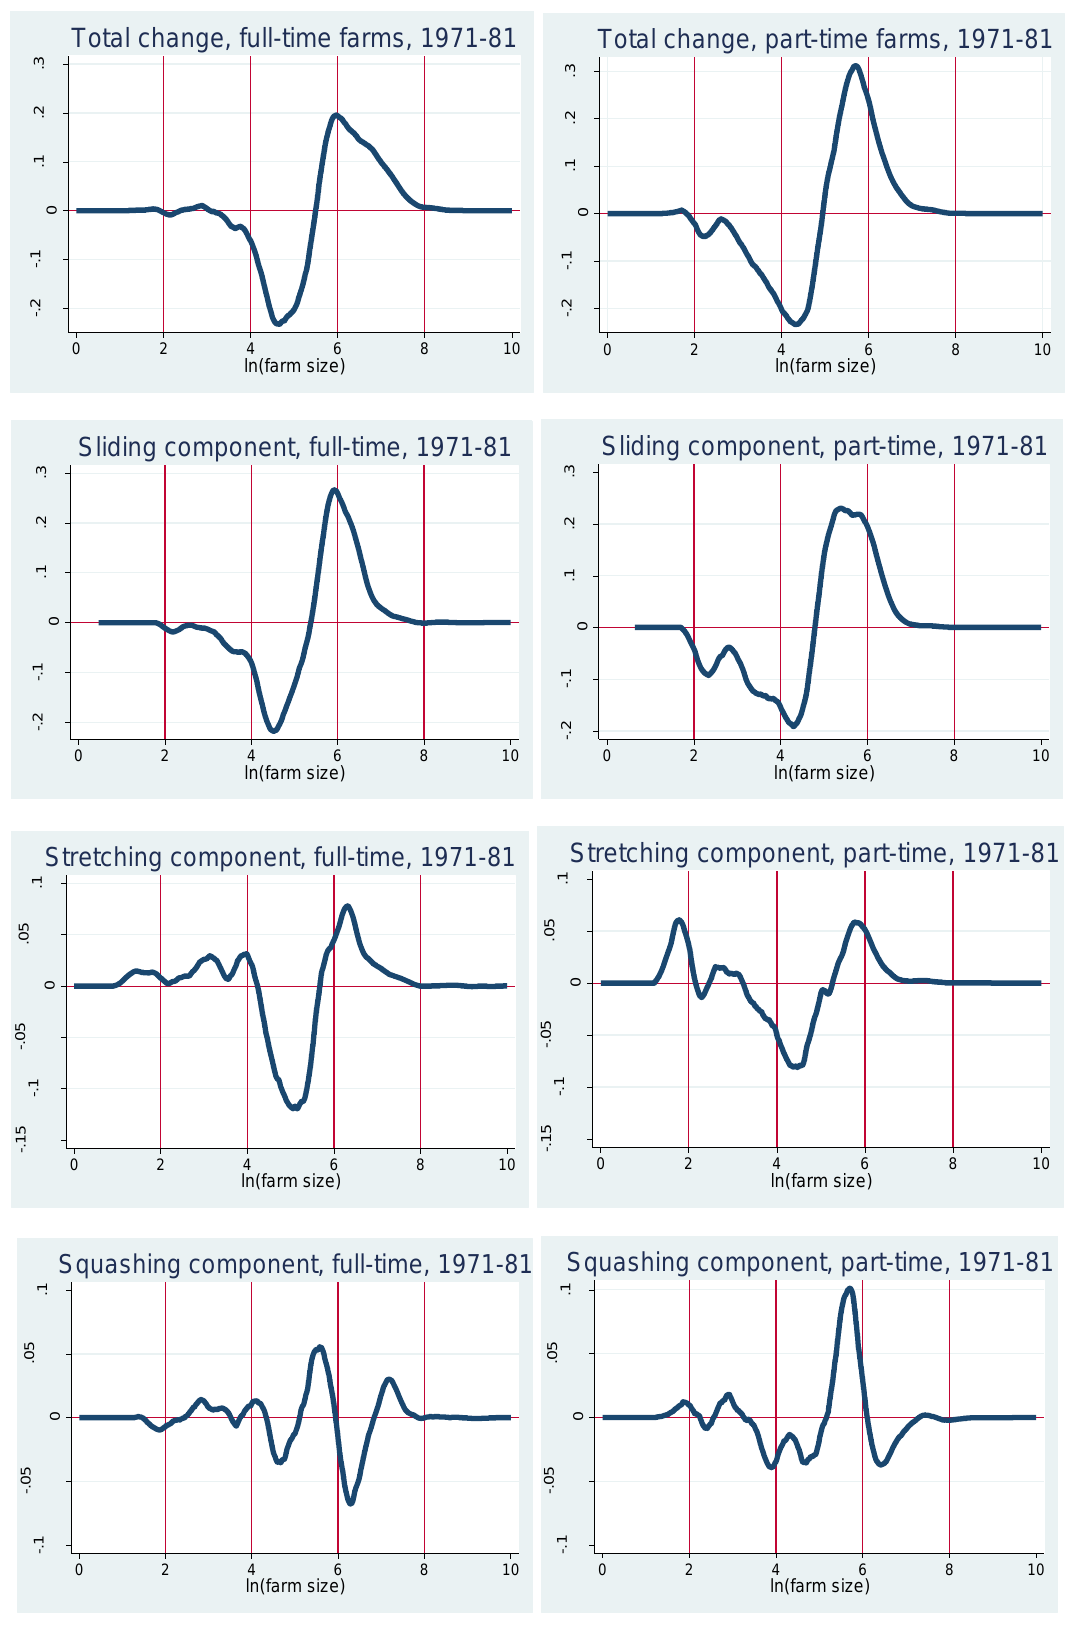
Figure 5. Decomposition of changes in farm size distribution, 1971 to 1981.